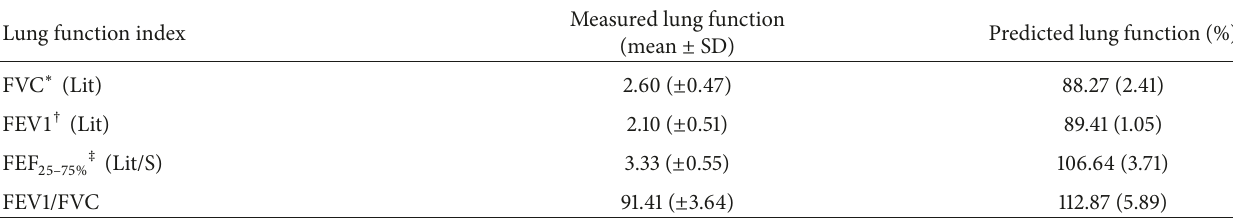
Table 4: The results of healthy participants’ spirometry tests.